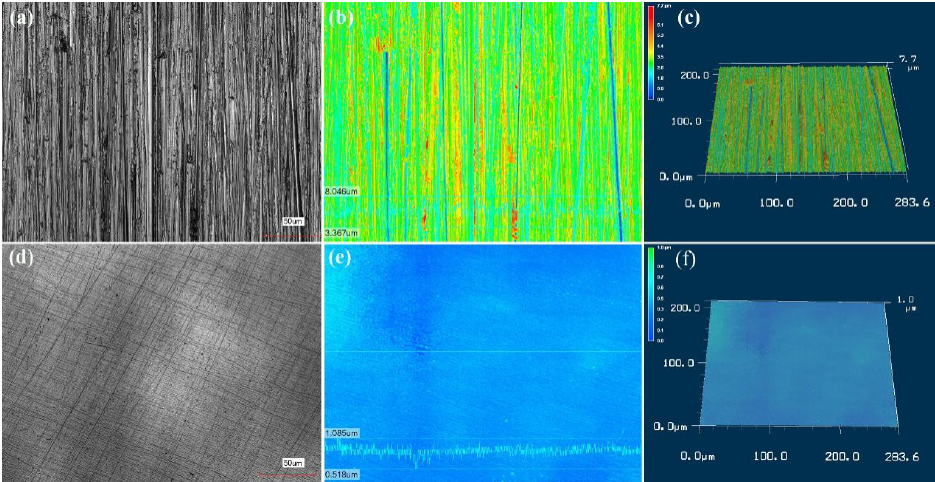
Figure 3. Surface morphology of samples. ( a–c ) Grinded surface and ( d–f ) polished surface.